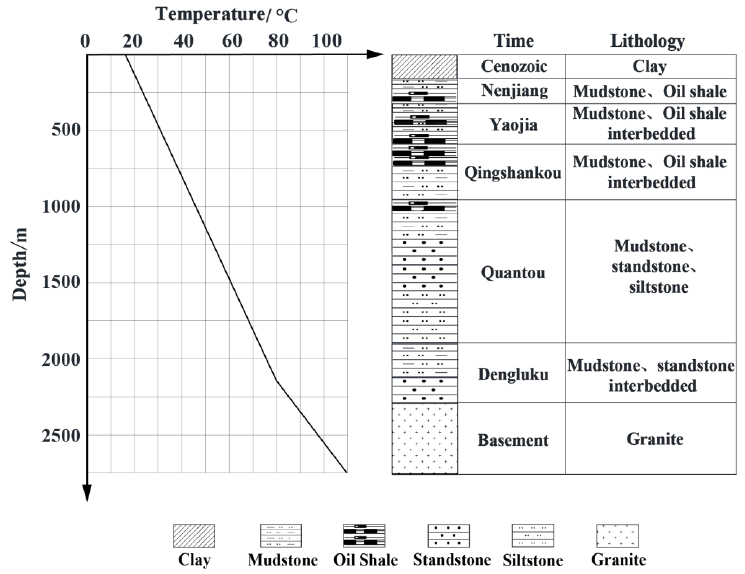
Figure 2. Lithology and well temperature records of research domain